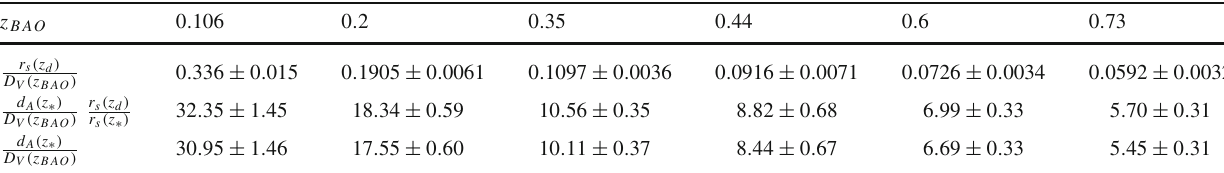
Table 1 Ratios of distances and the so-called dilation scale D V ( z BAO ) at different redshifts z BAO taken after [30–32] and